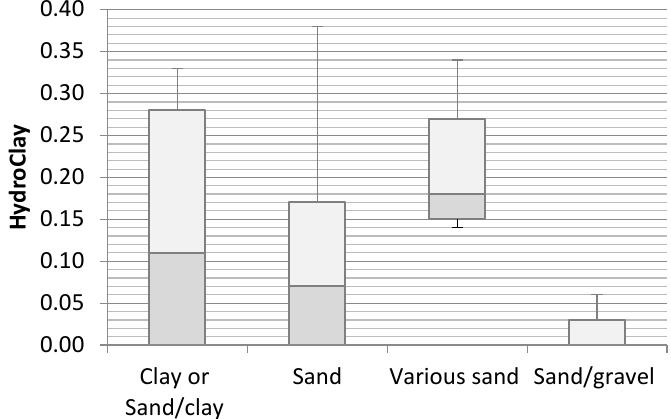
Figure 4. Volume of bentonite applied to specific fractions.